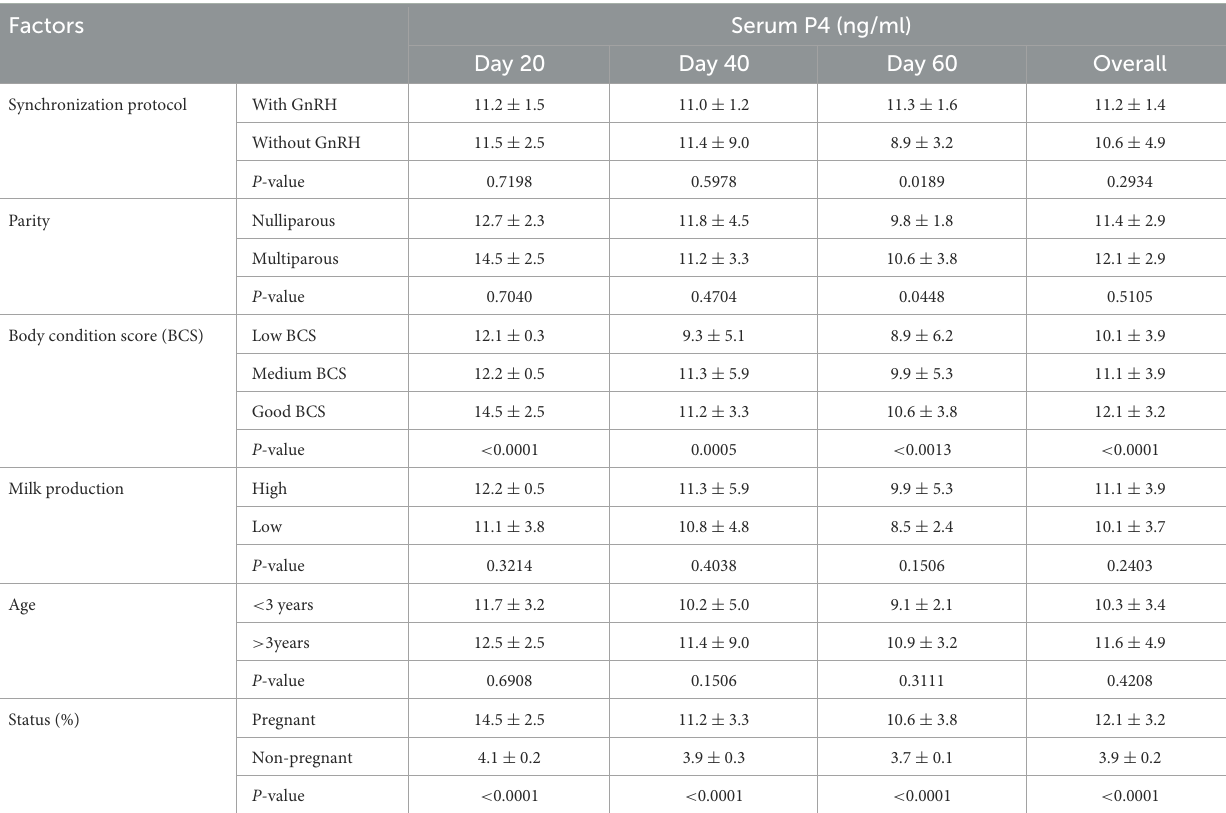
TABLE 3 Variation of P4 levels in buffaloes in response to synchronization protocol, parity, body condition score, age, milk production, and pregnancy status.